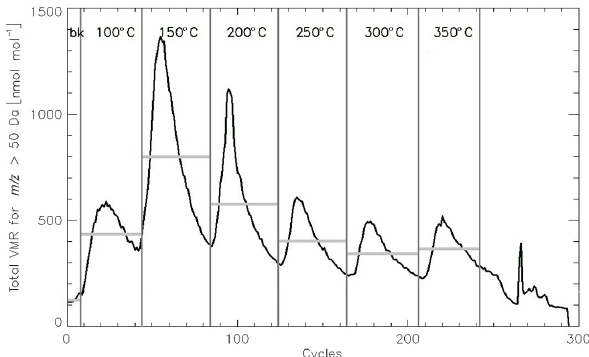
Figure 2. Analysis result of filter TRA10 by TD-PTR-MS. The fig- ure shows the total volume mixing ratios (VMRs) of all the ions above 50Da (in nmolmol − 1 ) with a temporal resolution of 5s. The vertical lines represent the heating steps as indicated at the top of the figure. The horizontal gray lines between these vertical lines are the concentration averages at each temperature step, and the back- ground level (bk; first horizontal gray line, close to zero) is sub- tracted from these values before further